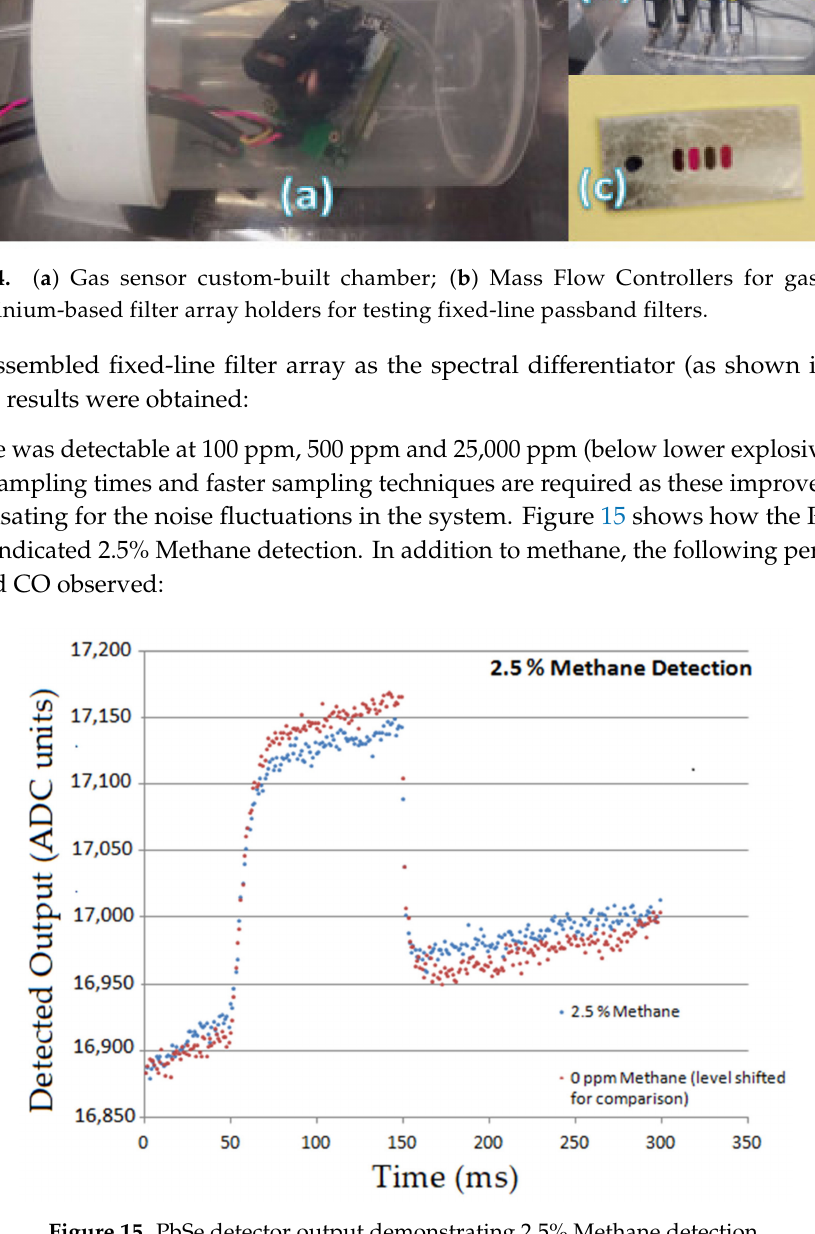
Figure 15. PbSe detector output demonstrating 2.5% Methane